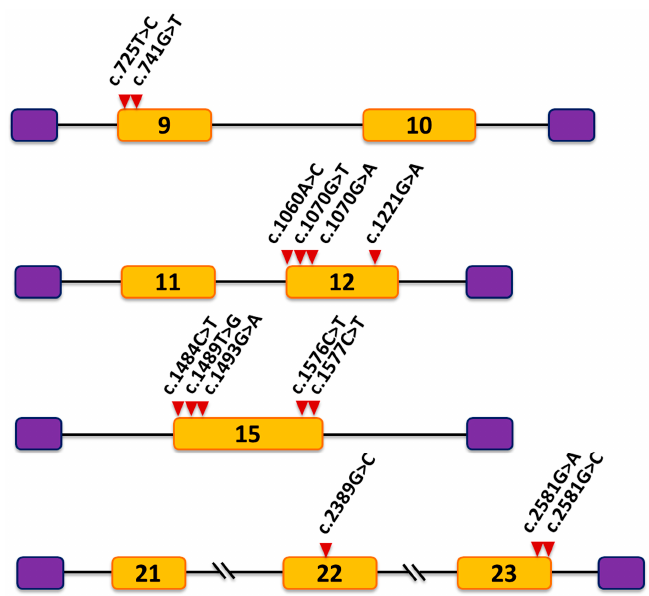
Figure 1. Schematic representation of the four minigenes constructed with expression vector pET01 and OCRL wild-type sequences (yellow boxes) containing exons 9-10 (pET-Ex9-10), 11-12 (pET-Ex11-12), 15 (pET-Ex15) and 21-22-23 (pET-Ex21-23), respectively. Purple boxes depict pET01 exons and horizontal lines in between indicate OCRL intron sequences. The different mutations introduced by site-directed mutagenesis in each minigene are shown.